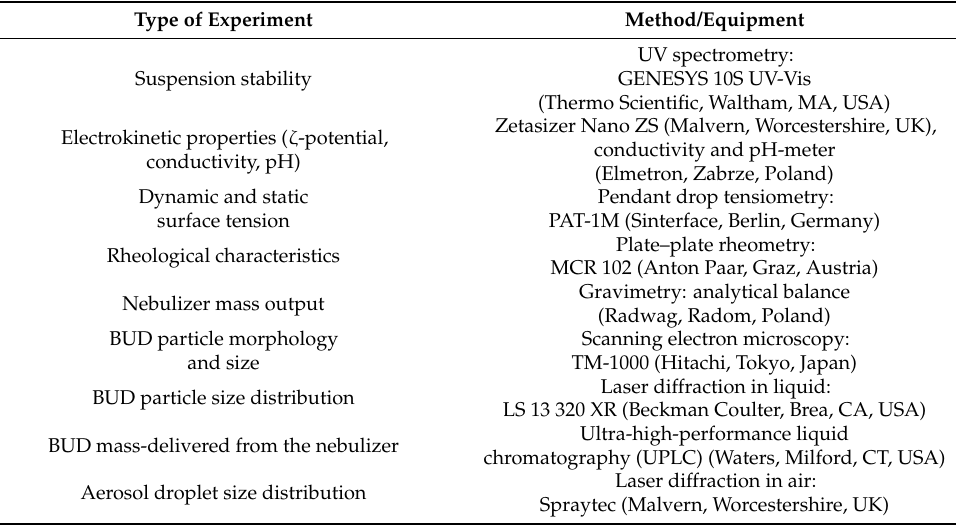
Table 2. Types of experiments for sample